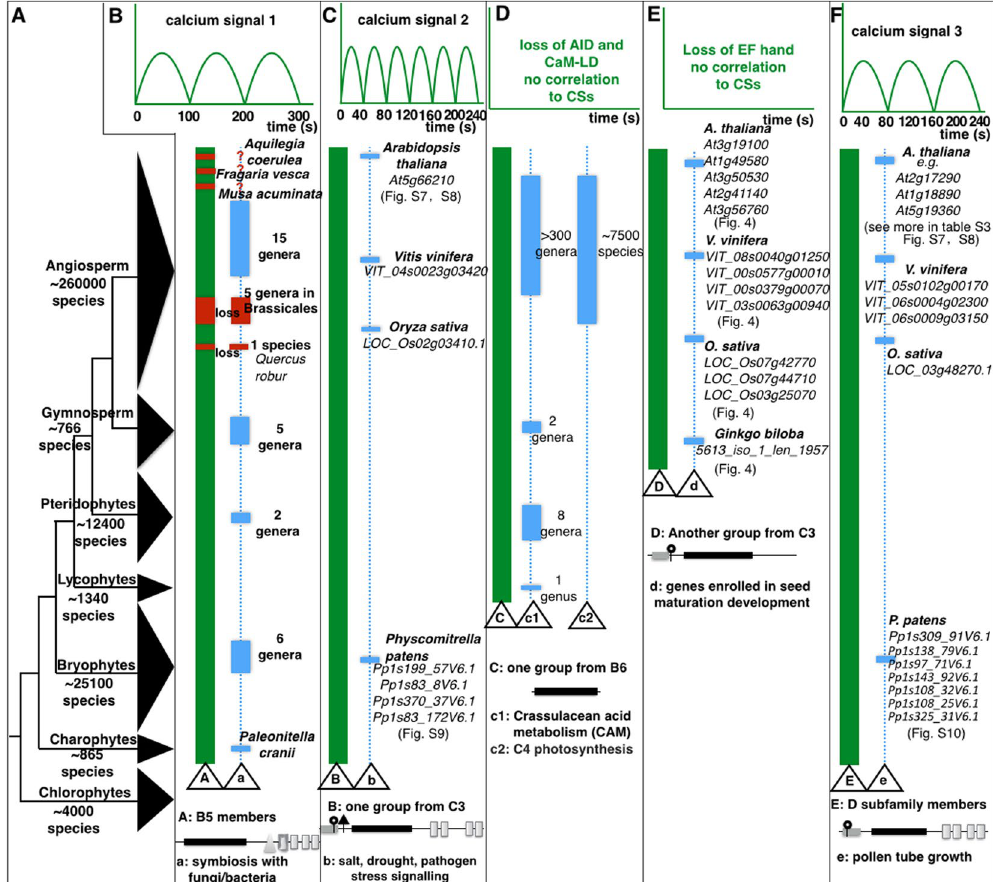
Figure 5. CFKs contribute to plant adaptation evolution. ( A ) Phylogeny and number of species among the lineages of green plants adapted from 54 . ( B ) The B5 CFKs receive low frequency CS and originated in charophytes, with functions dates back to charophyte alga-fungi symbiosis reported by 55 . ( C ) The high frequency CS that some B5 CFKs receive 36 . This group of genes shows myristoylation, palmitoylation, and acylation at the N-terminal and originated in charophyte, and act in the salt, drought, and pathogen stress signalling pathways. ( D ) The loss of auto-inhibitory domain (AID) and calmodulin-like domain (CaM-LD) of B6 genes caused these genes not activated by calcium. Both genes and crassulacean acid metabolism (CAM) originated in lycophytes whereas C4 photosynthesis was only found in angiosperms 56 . ( E ) This C3 subgroup of CFKs originated in the gymnosperm genomes. The loss of the EF hands also caused these genes not activated by calcium. Their roles in seed maturation development were found in seed plants. ( F ) The moderate frequency CS that some B5 CFKs receive. These genes have N-terminal myristoylation and palmitoylation and originated in charophytes. Their roles in male gamete maturation were confirmed in grapevine 38 , rice 57 , A. thaliana and P. patens . Capital letter in the triangle: gene group and its typical gene structure, small letter in the triangle: characterized gene functions. Solid vertical green bar: phylogenetic clade where genes are present; dotted vertical line indicates possible functions in these clades, and the solid blue bar in the dotted vertical line indicates species where gene functions have been